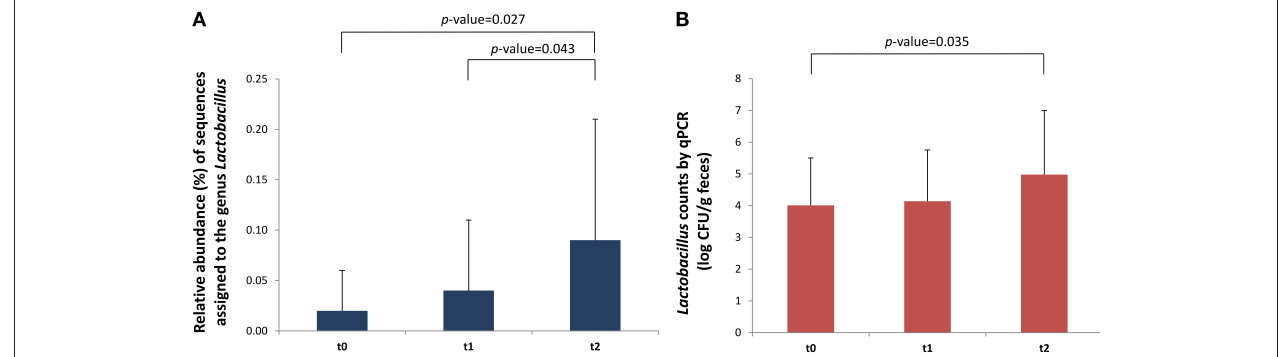
FIGURE 1 | Differences in Lactobacillus in fecal samples ( n = 8) of outgrowing NIM-CMPA infants (excluding those that consumed the probiotic LGG during the milk restriction period). Comparisons were made with the Wilcoxon signed-rank test to examine the differences over time ( t = 0, t = 1, and t = 2). (A) Relative abundance (%) of sequences belonging to the genus Lactobacillus determined through high-throughput sequencing of 16S rDNA amplicons. (B) Levels (log cfu/g of feces) of Lactobacillus group determined by qPCR. Means and standard deviations are represented.